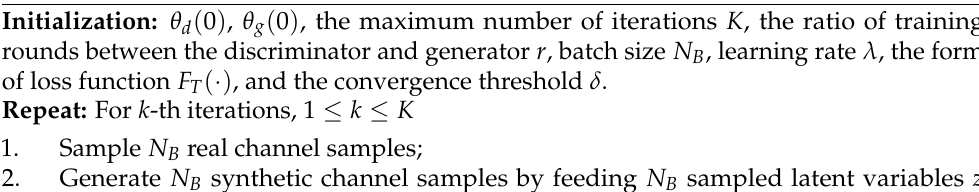
Algorithm 1 GAN-based synthetic channel samples